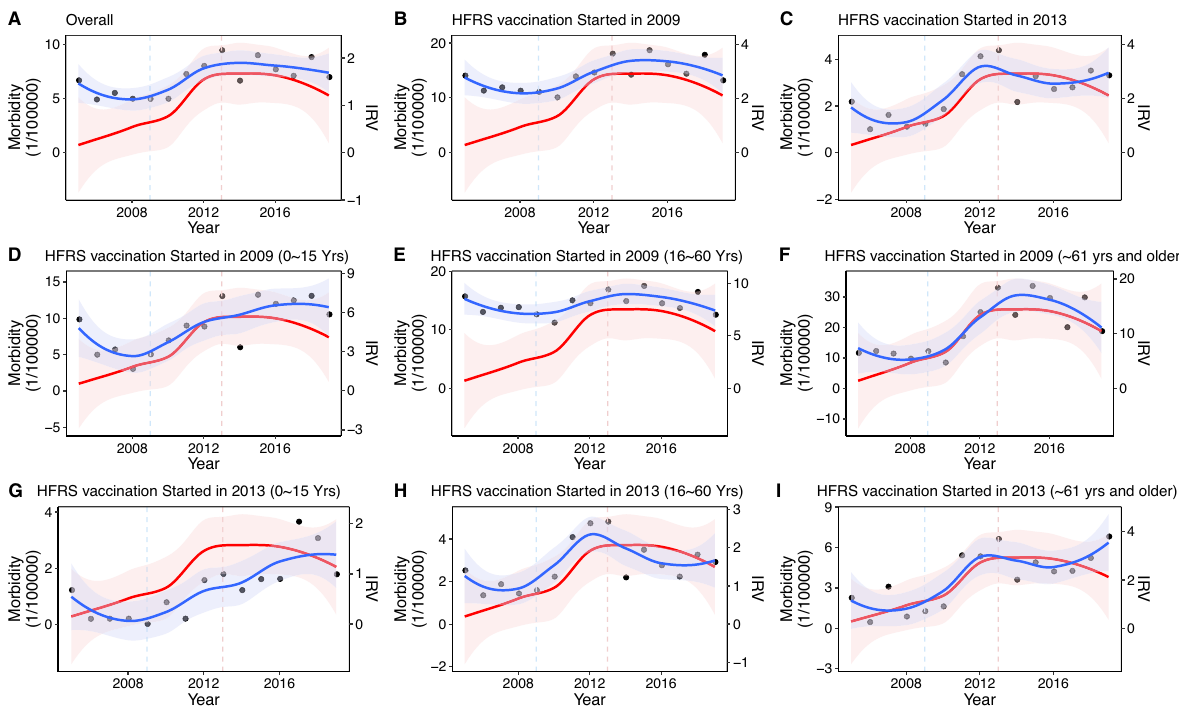
Figure 5. Correlation between human and rodent hantavirus from 2005 to 2021 in the counties surrounding Gaoan County. ( A ) shows the overall counties surrounding Gaoan County. ( B , D , E and F ) show the overall, 0 ~ 15, 16 ~ 60 and ~ 61 yrs and older subgroups in the counties that started HFRS vaccination in 2009, respectively. C, G, H and I show the overall, 0 ~ 15, 16 ~ 60 and ~ 61 yrs and older subgroups in the counties that started HFRS vaccination in 2013. The blue line is the HFRS morbidity fitted curve by loess regression, and the yellow line is the HFRS morbidity fitted curve by loess regression; the dots indicated the HFRS morbidity.